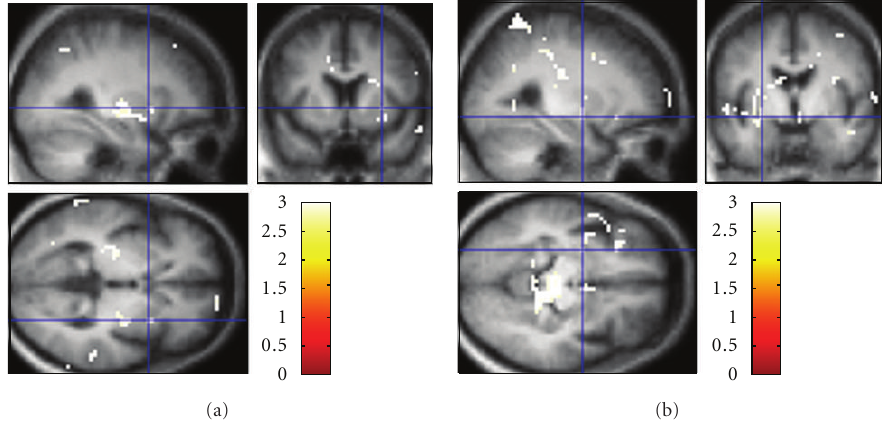
Figure 3: Statistical parametric (T) maps for correlations with arousal. (a) Positive correlation with arousal in right putamen (28.5, 6, 0). (b) Negative correlation with arousal in left amygdala-striatal transition area ( − 25.5, − 6, −